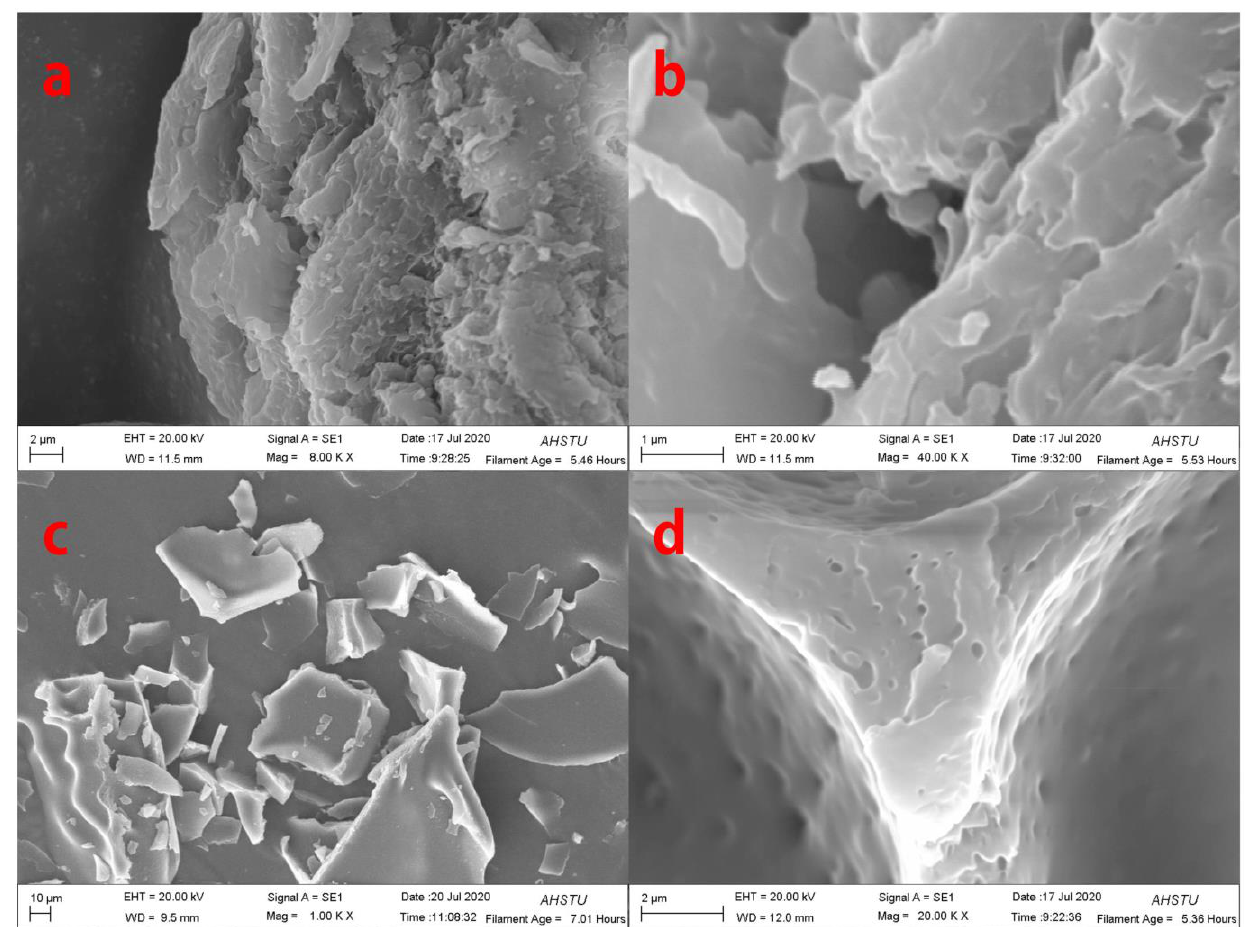
Figure 2. SEM images of ( a , c ) pig nail powders; and ( b , d ) pig nail